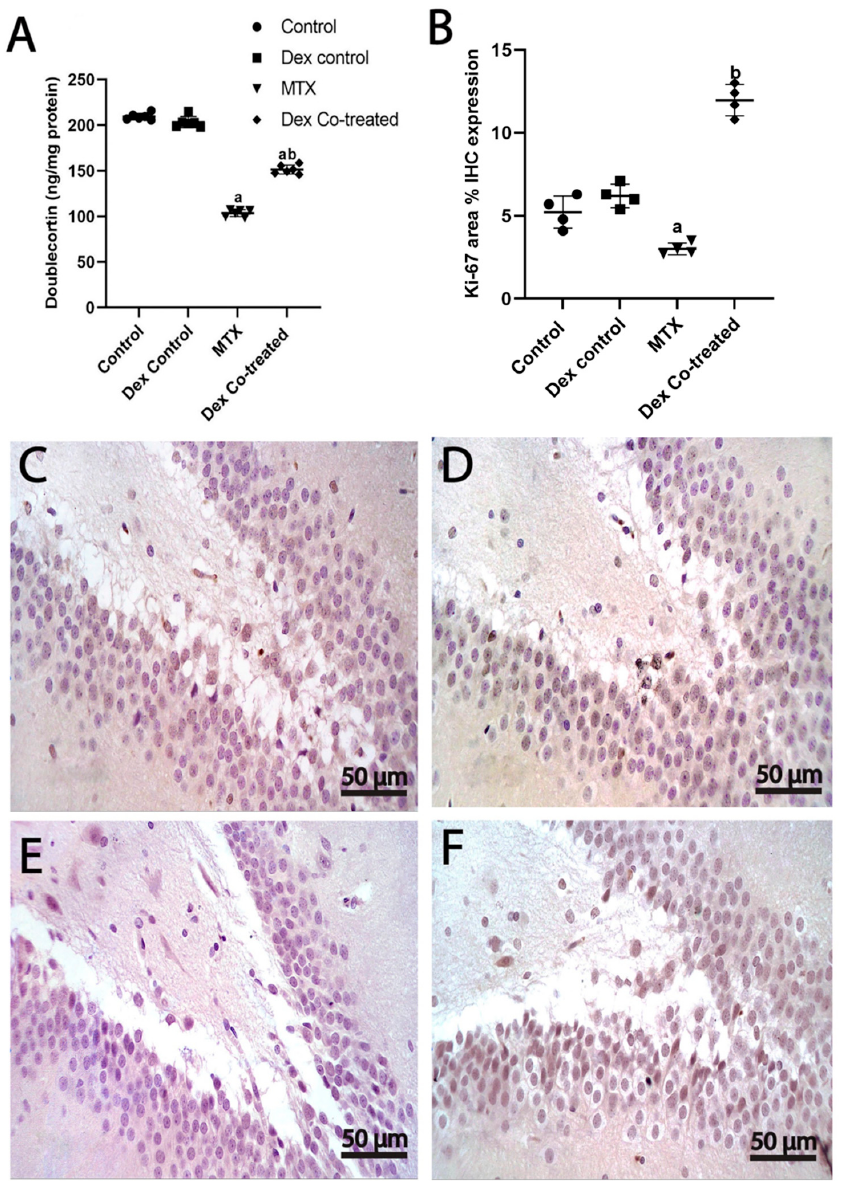
Figure 8. Effect of MTX and Dex on the number of immature neurons and cell proliferation. ( A )